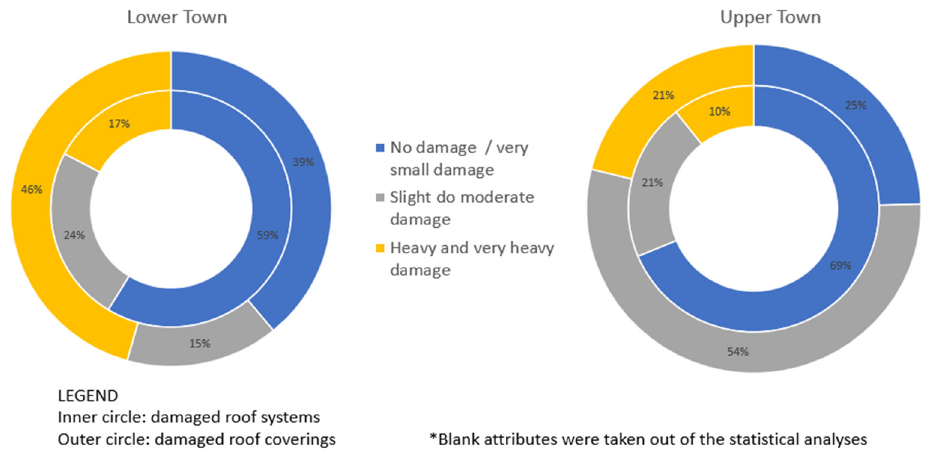
Figure 10. Damage to the timber roof systems and roof coverings in the two respected historic parts of Zagreb [13].